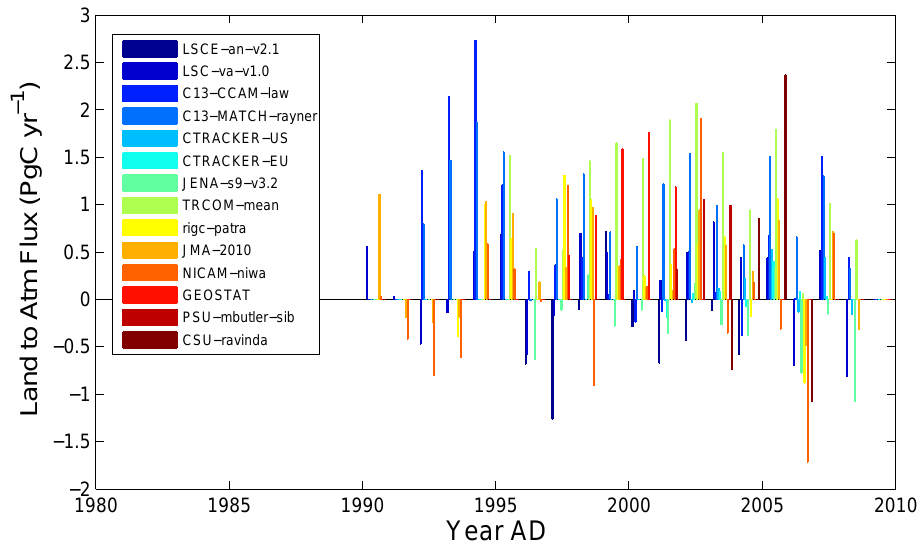
Fig. 10. Net carbon flux estimates from South American land to the atmosphere (i.e. a positive value is a flux to the atmosphere), estimated based on atmospheric CO 2 concentration data and inverse modelling of atmospheric transport using a range of specific mathematical inversion techniques prepared especially for